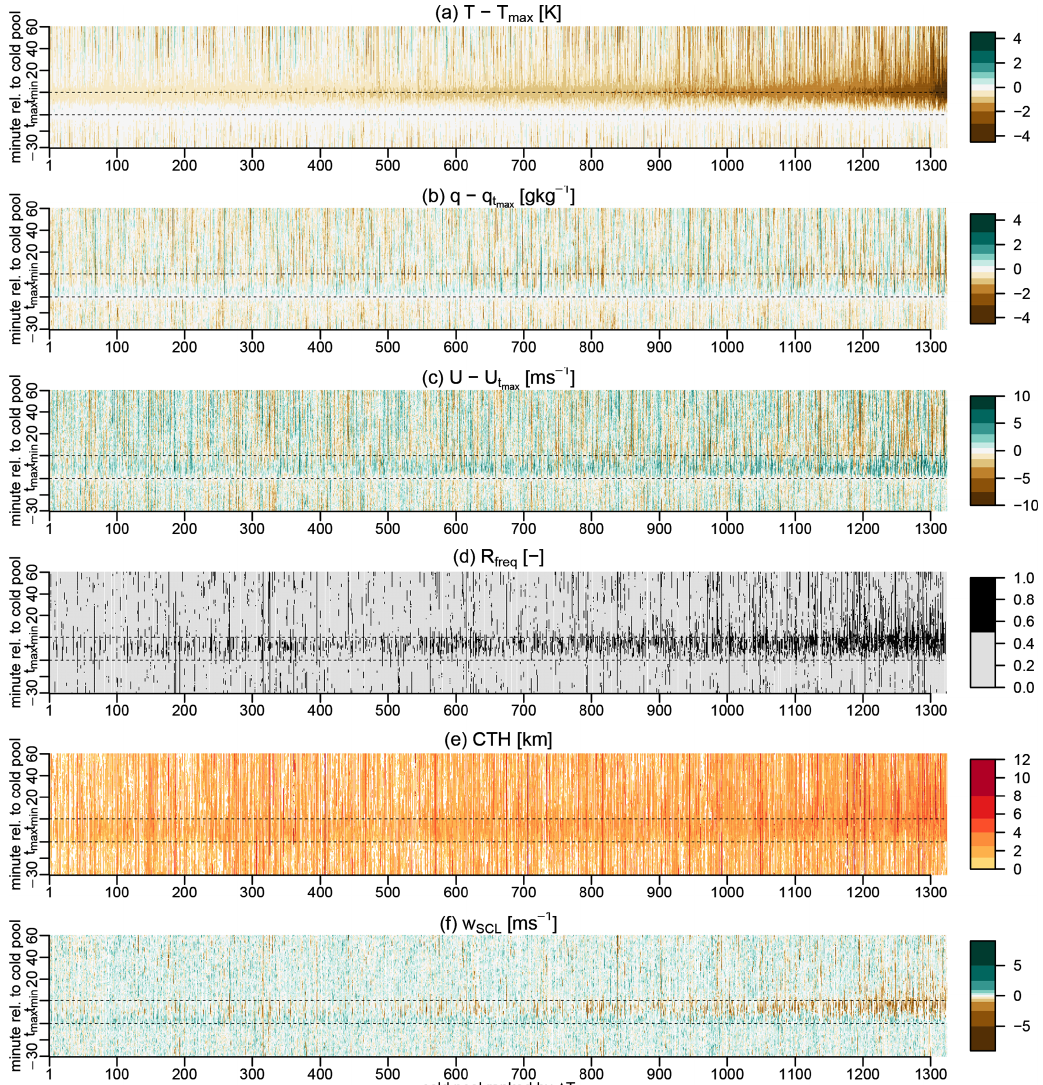
Figure 5. Temporal structure of individual cold pools ranked according to their (cid:49)T . Shown are all cold pools of noprevWI that have all instruments running. The panels show anomalies relative to the cold-pool onset ( t max ) for (a) temperature, (b) specific humidity, and (c) wind speed as well as absolute values of (d) the MRR rain frequency, (e) the cloud-top height, and (f) the vertical velocity averaged over the sub-cloud